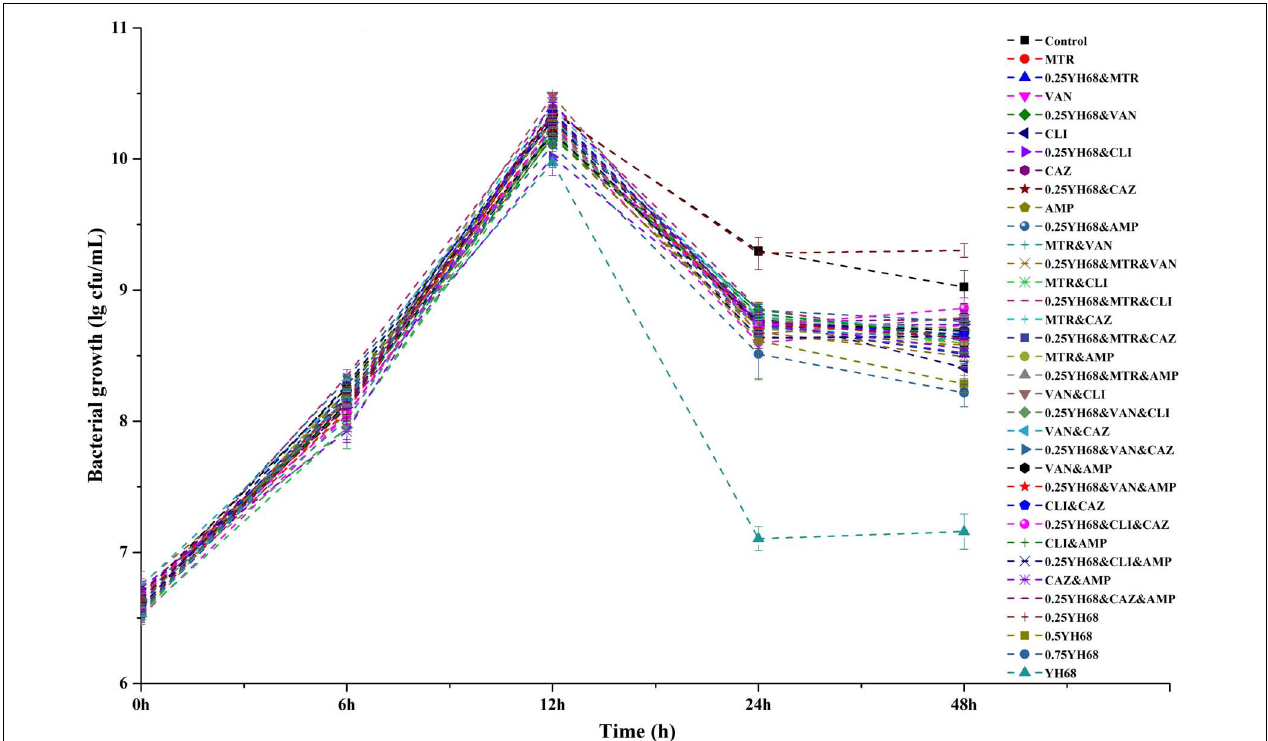
FIGURE 1 | Effects of different combinations on the growth of Clostridium difficile ATCC